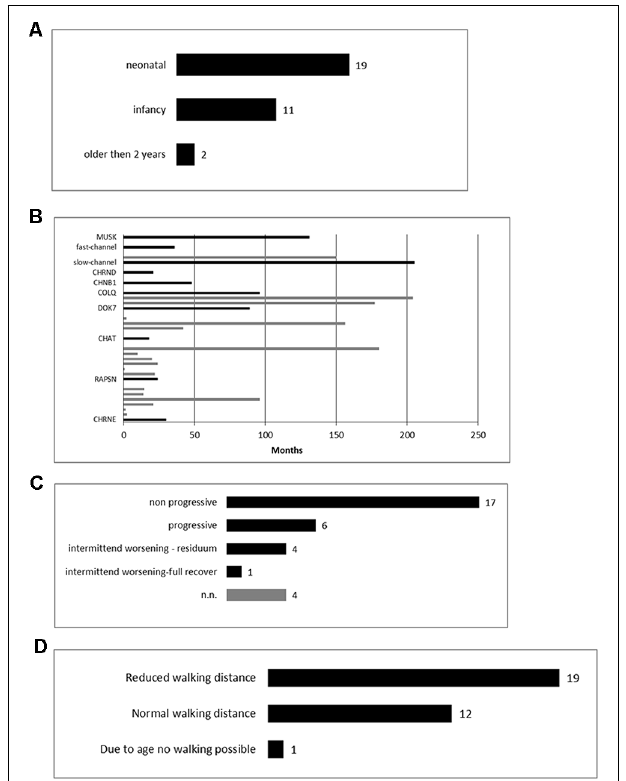
FIGURE 1 | Clinical findings of our overall congenital myasthenic syndromes (CMS) cohort. (A) Age of clinical manifestation of the symptoms ( n = 32). (B) Time from onset of the first symptoms to diagnosis ( n = 29). (C) The clinical course of the patients ( n = 32). (D) Walking distance at the point of clinical evaluation ( n =